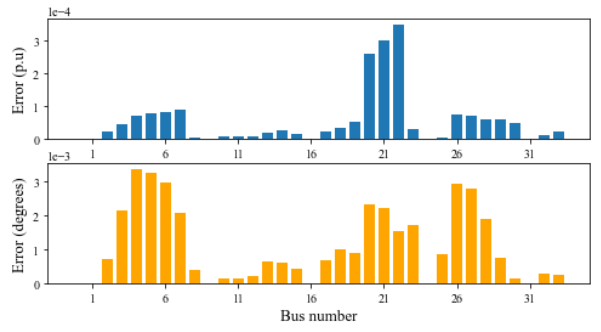
Figure 13. State estimation error (OP): 33-bus system, N m = 4.